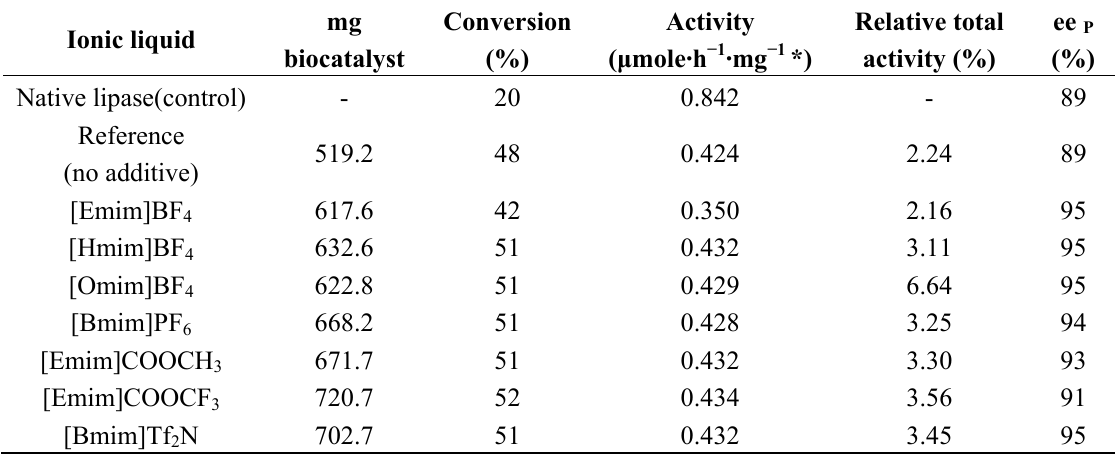
Table 2. Influence of IL used as additive on catalytic efficiency of sol-gel entrapped CaLB lipase in enantioselective acylation of racemic 2-octanol, at 24 h reaction time.